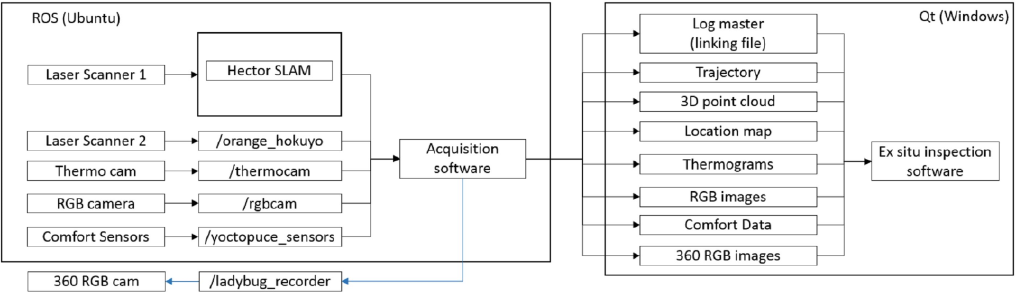
Figure 7. Overall software architecture of the IMAS system. The blue arrow represents the panoramic camera triggering.